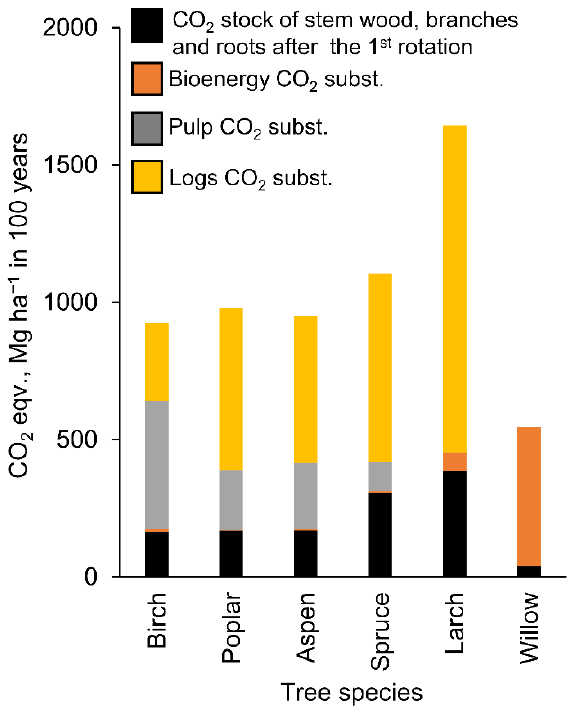
Figure 2. The climate benefit per hectare expressed as the sum of removed CO 2 from the atmosphere due to increased carbon stocks and avoided CO 2 -emissions related to substitution effects over 100 years for the studied tree species.